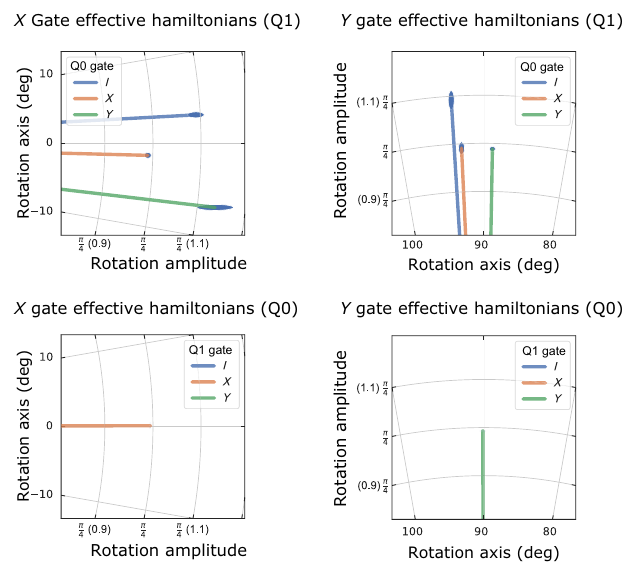
FIG. 5. Coherent errors in X π/ 2 and Y π/ 2 gates on QSCOUT qubits depend on context. We use GST to estimate one-qubit process matrices describing the X π/ 2 (left) and Y π/ 2 (right) gates on Q0 (bottom) and Q1 (top), conditional on { I , X π/ 2 , and Y π/ 2 } gates performed at the same time on the other qubit, in the QSCOUT system. Exactly as for Fig. 3, we extract the effec- tive Hamiltonian that generates the unitary part of each estimated (cid:11) process (see the main text), represent it as H eff = h · (cid:11) σ [with (cid:11) σ = ( X , Y , Z ) ], and plot the projection of each one into the X - Y plane (all h Z components are negligible). Each of the four panels shows a small region of the X - Y plane; each effective Hamiltonian is represented by a line from the origin to ( h X , h Y ) . Uncertainty regions are shown as ellipses. Q0’s gates show essentially no context dependence. In contrast, the rotation angles and axes of the X π/ 2 and Y π/ 2 gates on Q1 show extremely strong depen- dence on the gate performed on the spectator. We also observe small context-dependent phase errors in the I gate (not shown